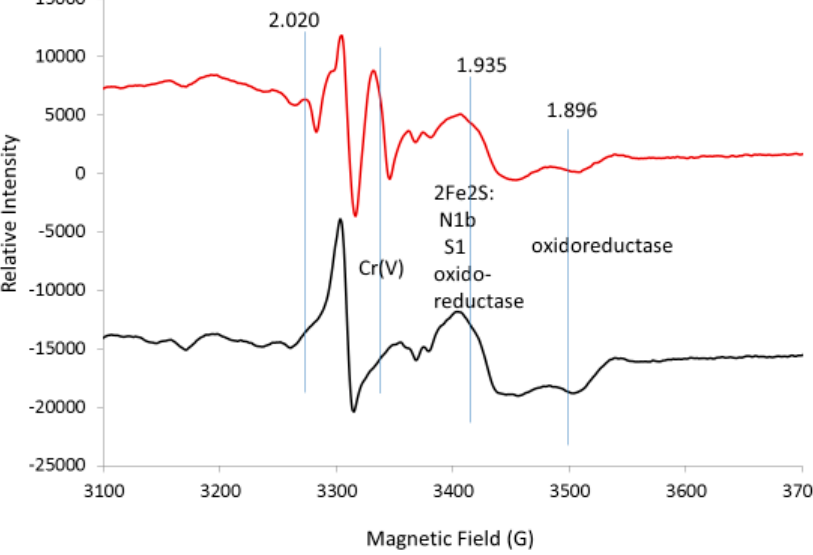
Figure 4. EPR spectra for control liver tissue (black) versus liver treated with chromate (red). The vertical lines indicate the g-values for EPR lines from Complex I (N1b), Complex II (S1) and the 2Fe2S site in xanthine oxidoreductase as discussed in the text. Spectrometer conditions: microwave freq., 9.272 GHz; temp., 110 K; mod. amp., 5 G; microwave power, 20 mW; sweep time, 83.89 s; time constant, 81.92 ms.